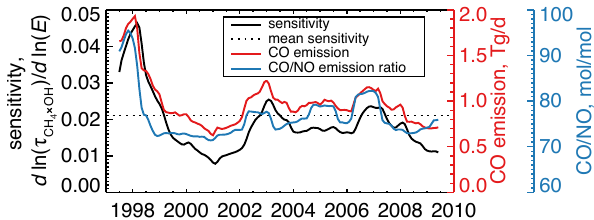
Fig. 4. Sensitivity of τ CH to biomass burning emissions, E , 4 × OH in the UCI CTM. Biomass burning CO emissions and the CO/NO emission ratio from the GFED3 inventory are also shown. Peak emissions and peak CO/NO ratio occur during El Ni˜no events, due to tropical peat